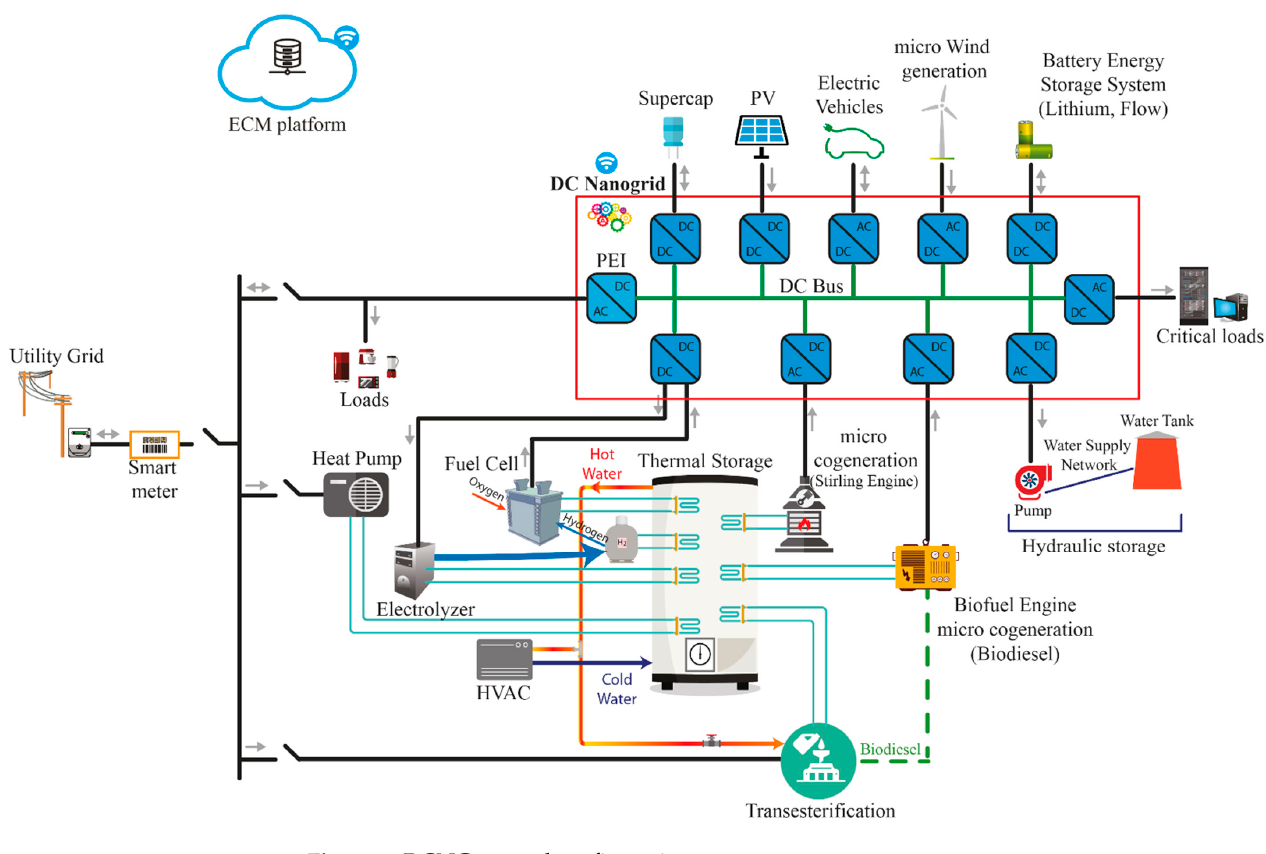
Figure 3. DCNG general configuration.